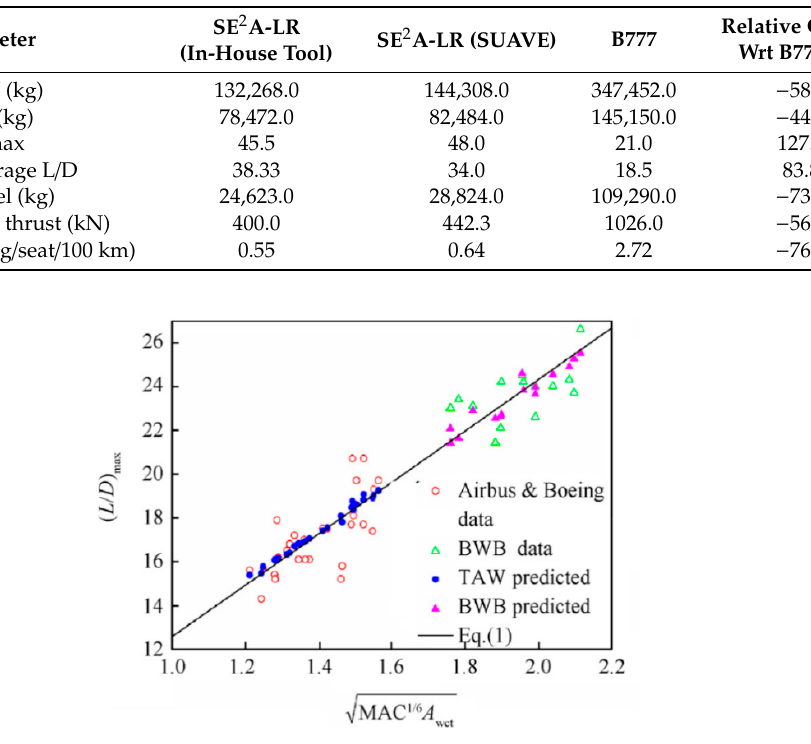
Figure 4. Summary of maximum L/D for various types of aircraft [32].